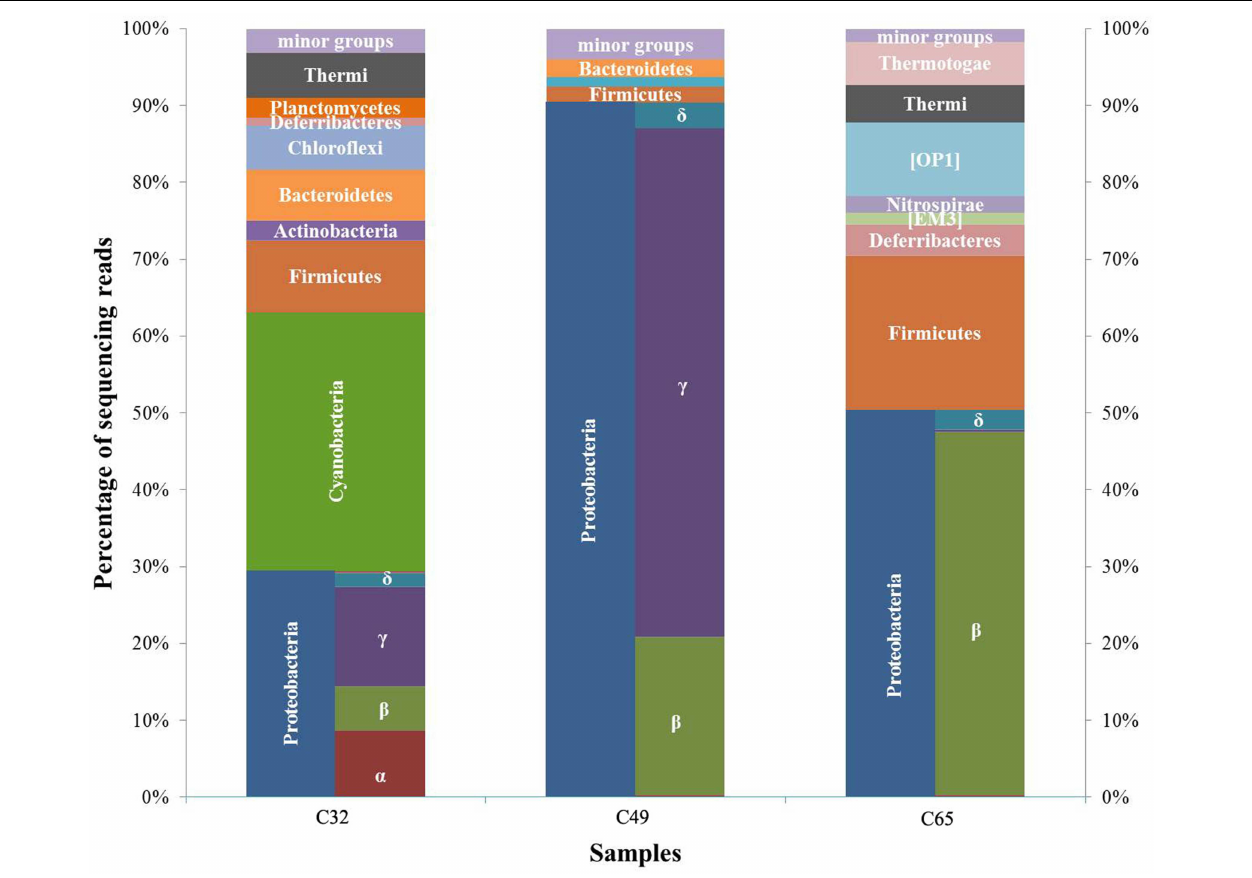
FIGURE 5 | Distribution of major bacterial phyla and classes in the carbonate deposits from Ciocaia based on the percent of sequencing reads that could be attributed to Operational Taxonomic Units (OTUs) within specific bacterial